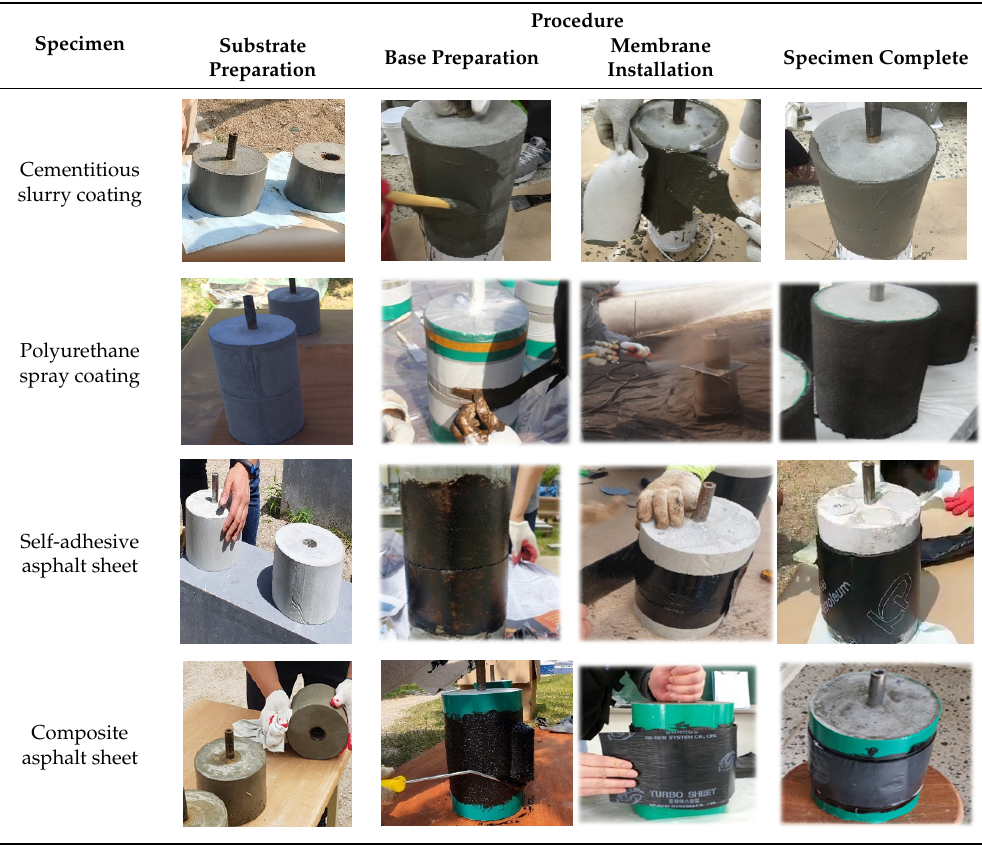
Table 6. Four waterproofing system specimens’ installation process.